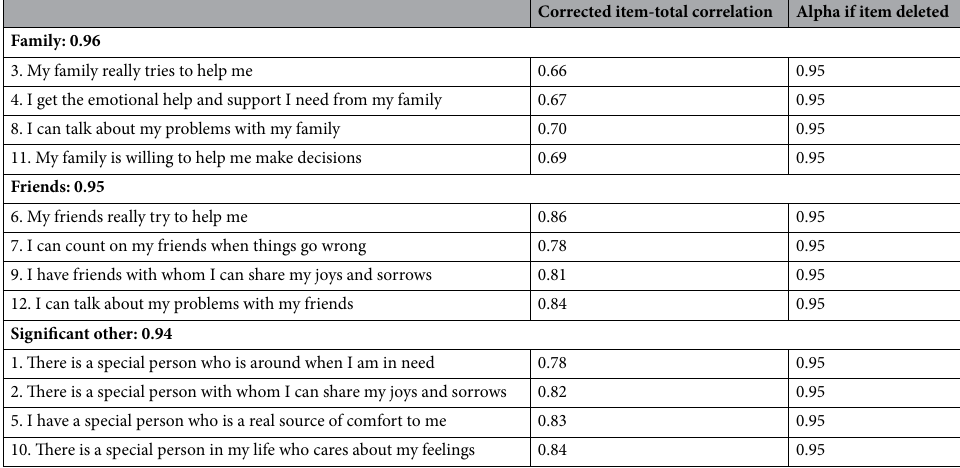
Table 2. Internal consistency of MSPSS-C in people with stroke.